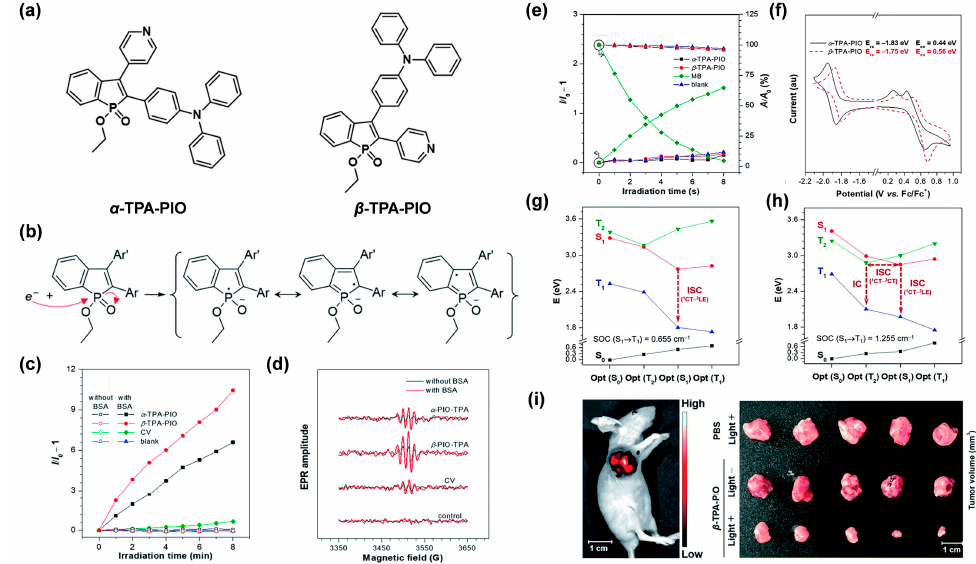
Figure 2. ( a ) The chemical structures of α -TPA-PIO and β -TPA-PIO. ( b ) Resonance structures of the PIO radical ions. ( c ) Relative fluorescence intensity of hydroxyphenyl fluorescein (HPF) for OH • detection. ( d ) Electron spin resonance (ESR) signals of 5-tert-butoxycarbonyl-5-methyl-1-pyrroline-N- oxide (BMPO) for free radical ROS detection of α -TPA-PIO and β -TPA-PIO with or without bovine serum albumin (BSA). ( e ) Relative fluorescence intensity of singlet oxygen sensor green (SOSG) and decomposition rates of 9,10-anthracenediyl-bis(methylene) dimalonic acid (ABDA) for 1 O 2 detection of α -TPA-PIO, β -TPA-PIO and MB. ( f ) Cyclic voltammograms of α -TPA-PIO and β -TPA-PIO. SOC value and ISC process of ( g ) α -TPA-PIO, and ( h ) β -TPA-PIO. ( i ) Images of mouse and tumors at 24 h post-injection of β -TPA-PIO. Reprinted with permission from [48], copyright 2020, Royal Society of Chemistry.